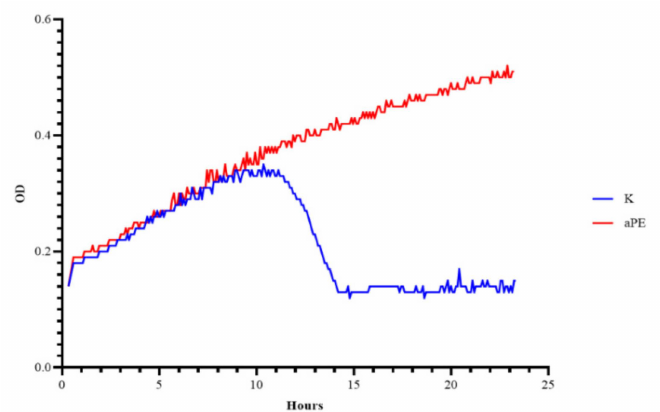
Figure 5. OD over time for P. syringe incubated with Φ 6 phages after their incubation with the aPE (phages were added when OD = 0.2, amount of phage MOI = 1). K—PE film; aPE—PE film containing a mixture of CO 2 extracts of raspberry seeds, pomegranate seeds, and rosemary in polymer